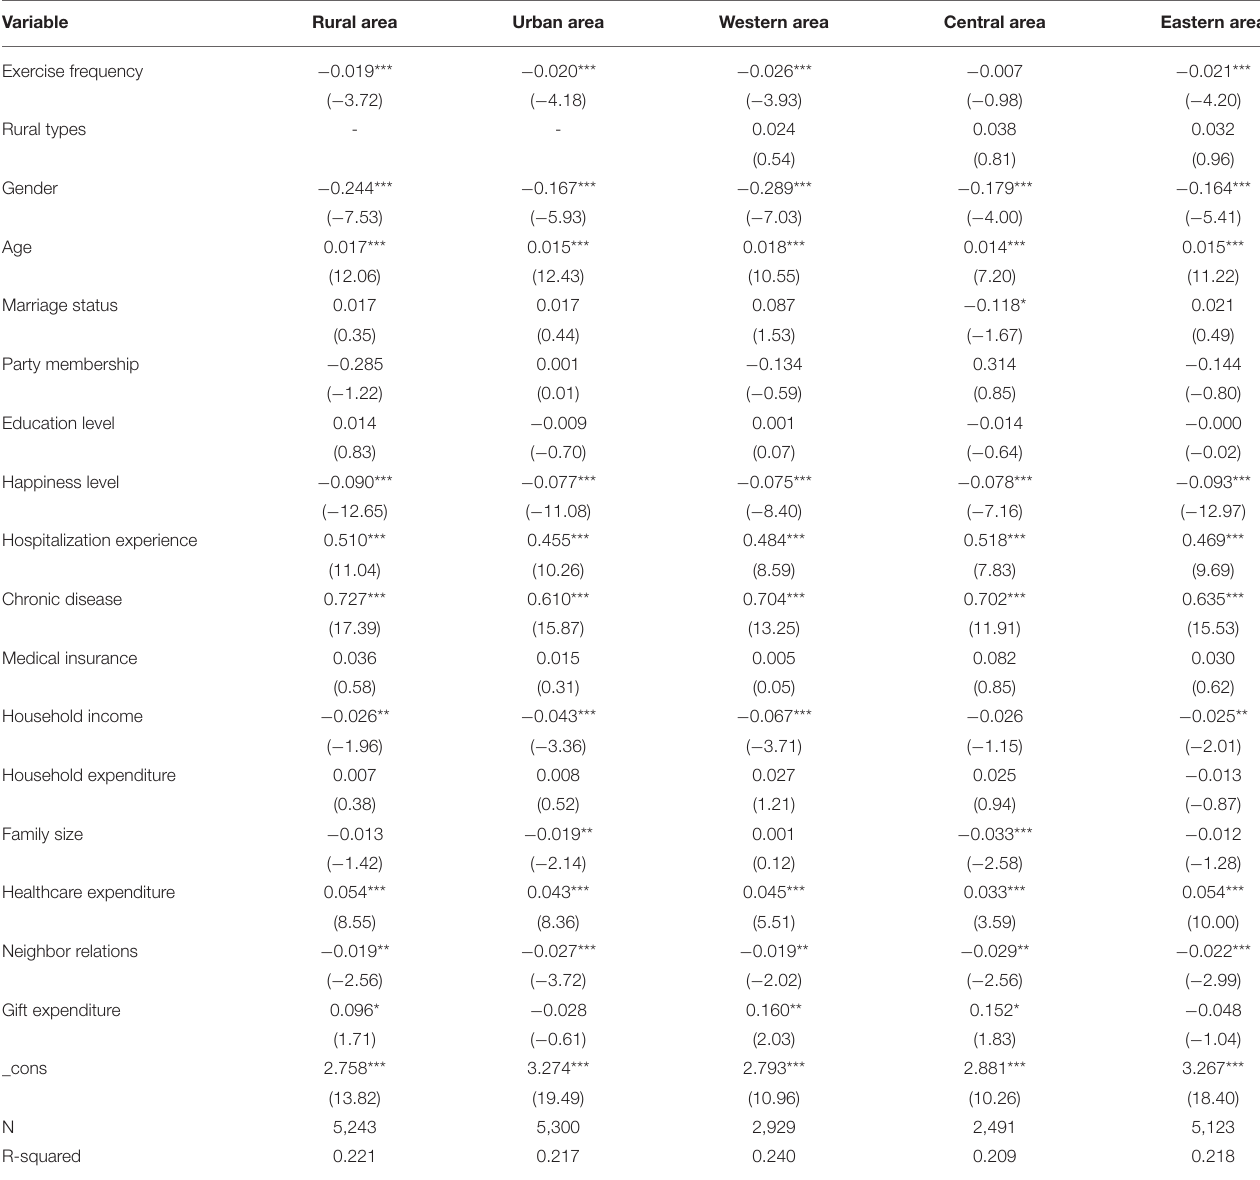
Taking into account the basic national conditions of the dual structure of urban and rural areas in China, there are significant differences in lifestyles between rural residents and urban residents; the ways of participating in physical exercise are also different (13); and urban and rural income levels are different. Conversely, the allocation of medical resources is also different (8); the environmental indicators in rural areas and the green space that can be provided for physical exercise are also different from those in cities (21). So we will analyze the differences between urban and rural areas. From the perspective of urban–rural differences, exercise frequency is significant